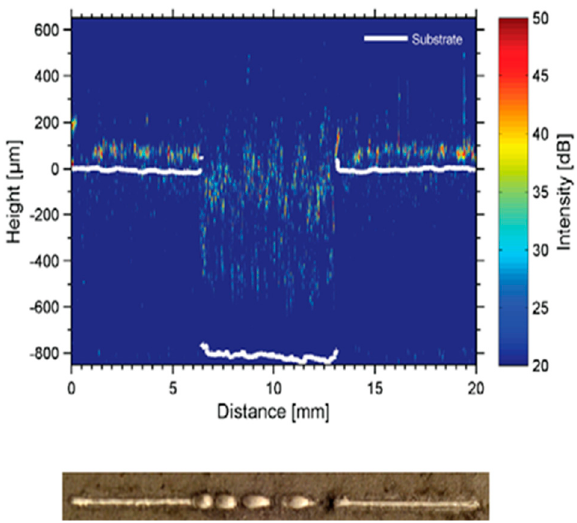
Figure 11. Single − channel SLM pool monitoring based on low coherence interference [41].